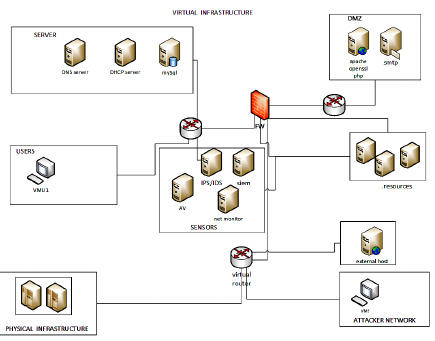
Figure 4. Generic topological view of the deployed